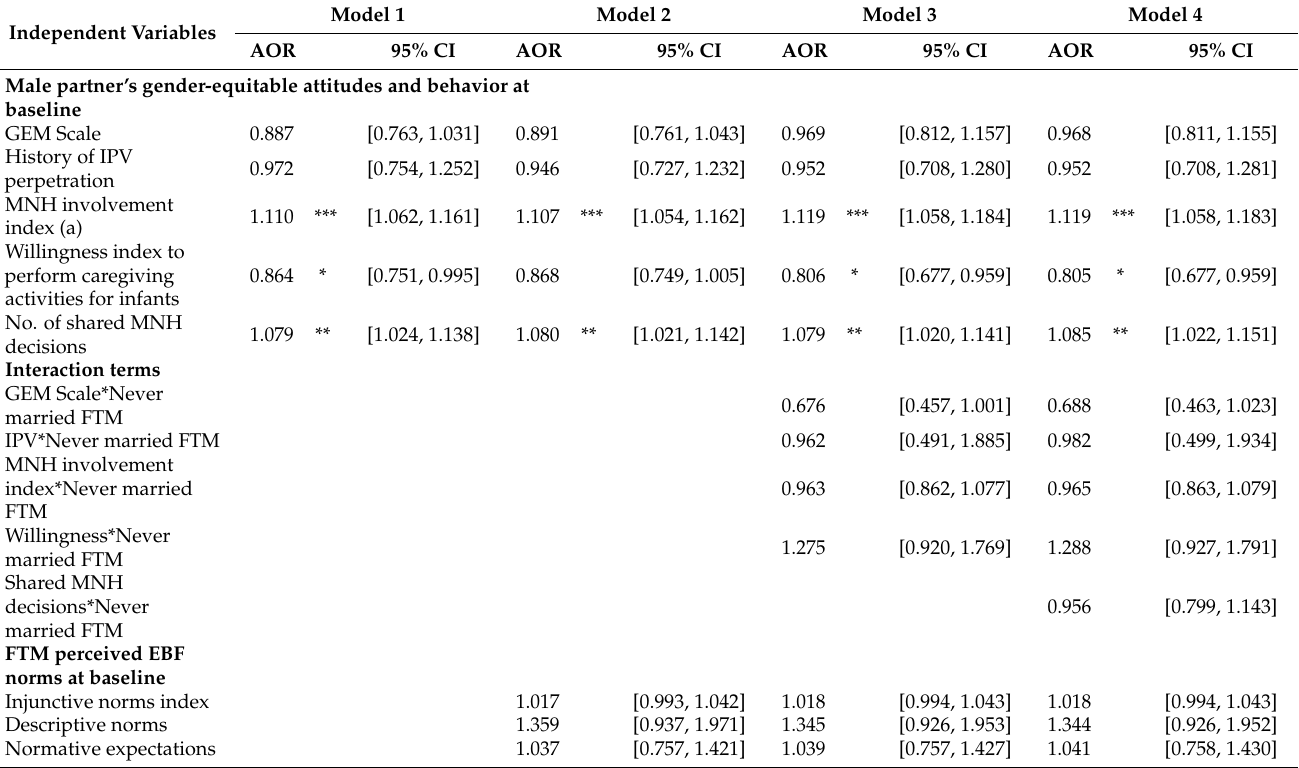
Table 8. Results of multivariable logistic regression models of exclusive breastfeeding for six months among first-time mothers age 15–24, Kinshasa,